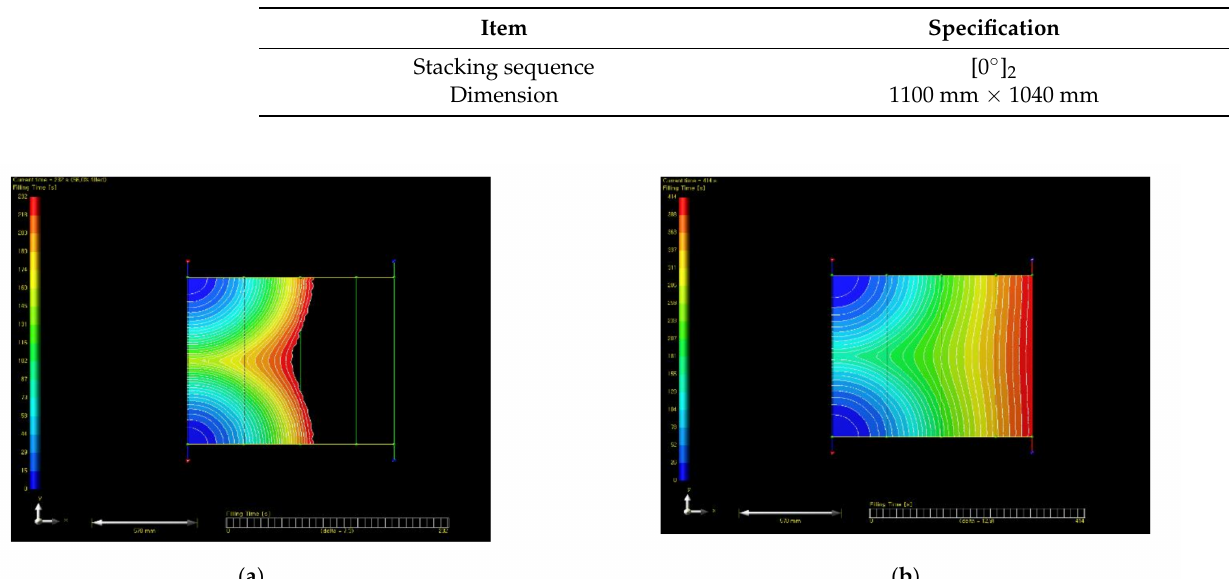
Figure 6. The resin flow analysis result of plate.: ( a ) t = 232 s (56% filled); ( b ) t = 414 s (100% filled).